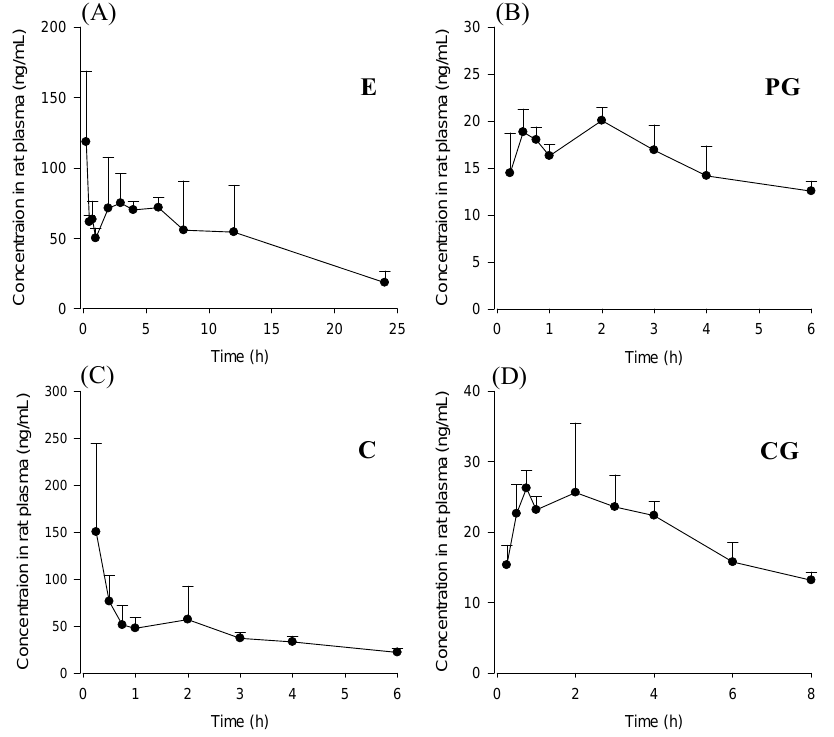
Figure 4. Mean plasma concentration–time profiles after oral ( n = 3) administration of R. acetosa extract (2 g/kg) to SD male rats. Bars represent standard deviation. ( A ) emodin; ( B ) physcion ‐ 8 ‐ O ‐β‐ D ‐ glucoside; ( C ) chrysophanol; ( D ) chrysophanol ‐ 8 ‐ O ‐β‐ D ‐ glucoside.